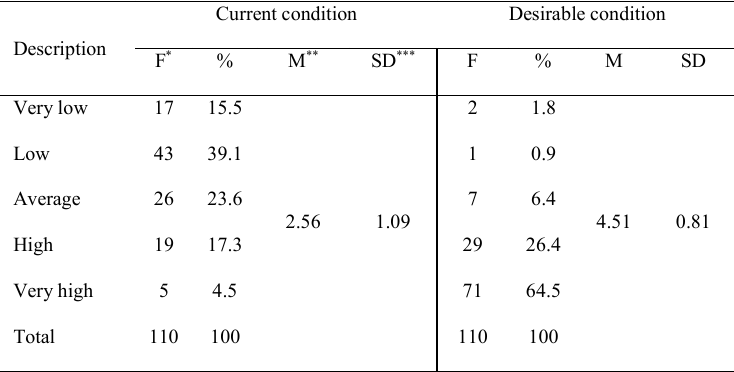
* Frequency, ** Mean, *** Standard